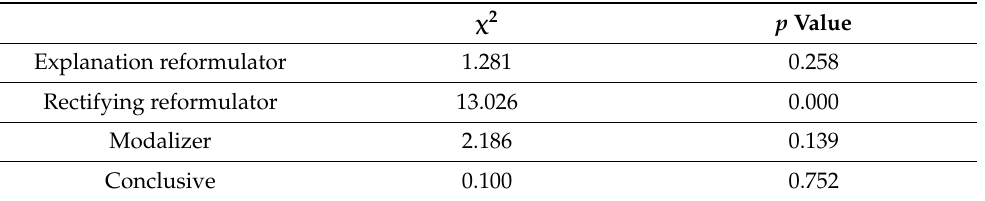
Table 3. Data from the Kruskal–Wallis ANOVA on the functions of vamos and the gender variable. χ 2